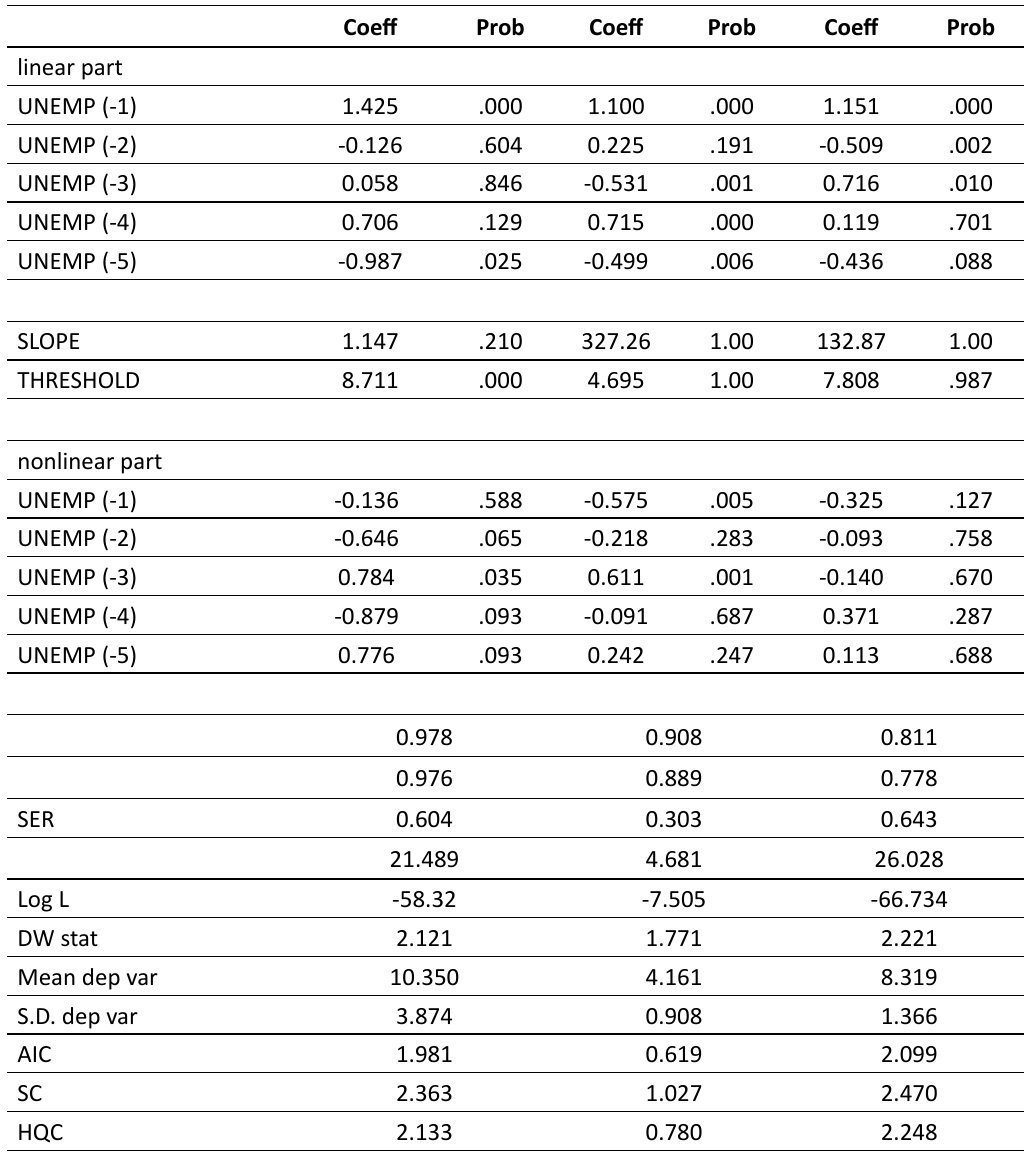
Table 5: Smooth Transition